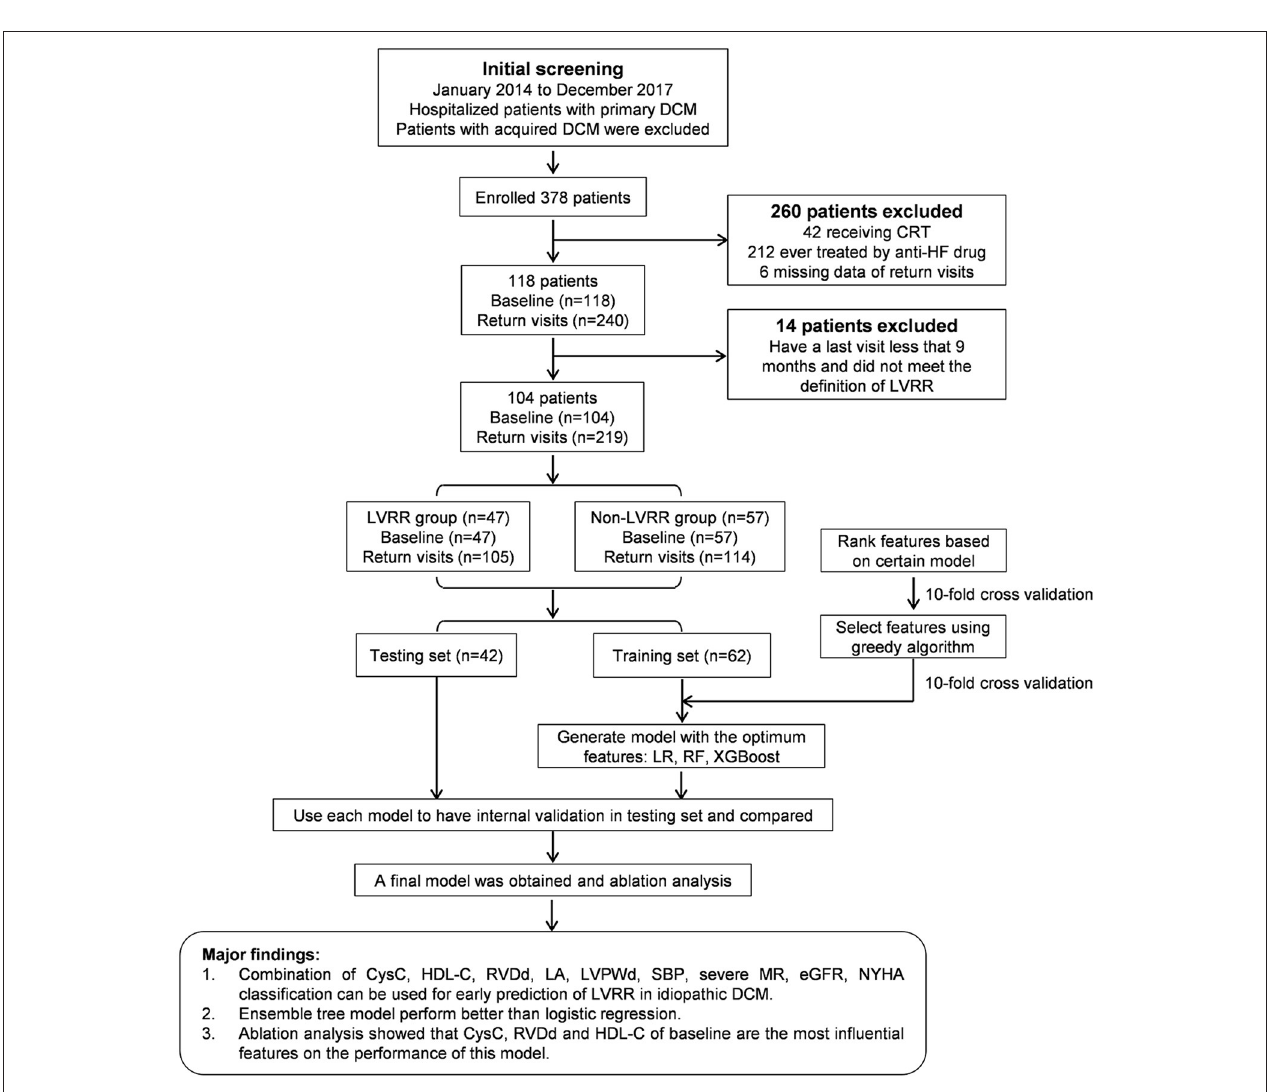
FIGURE 1 | Overall flowchart and main results of this study. CRT, cardiac resynchronization therapy; CysC, cystatin C; DCM, dilated cardiomyopathy; eGFR, estimated glomerular filtration rate; HDL-C, high-density lipoprotein cholesterol; HF, heart failure; LA, left atrial dimension; LVDd, left ventricular end-diastolic diameter; LVEF, left ventricular ejection fraction; LVPWd, left ventricular posterior wall dimension; LVRR, left ventricular reverse remodeling; LR, logistic regression; MR, mitral regurgitation; NYHA, New York Heart Association; RF, random forest; RVDd, right ventricular end-diastolic dimension; SBP, systolic blood pressure; XGBoost, extreme gradient boosting.